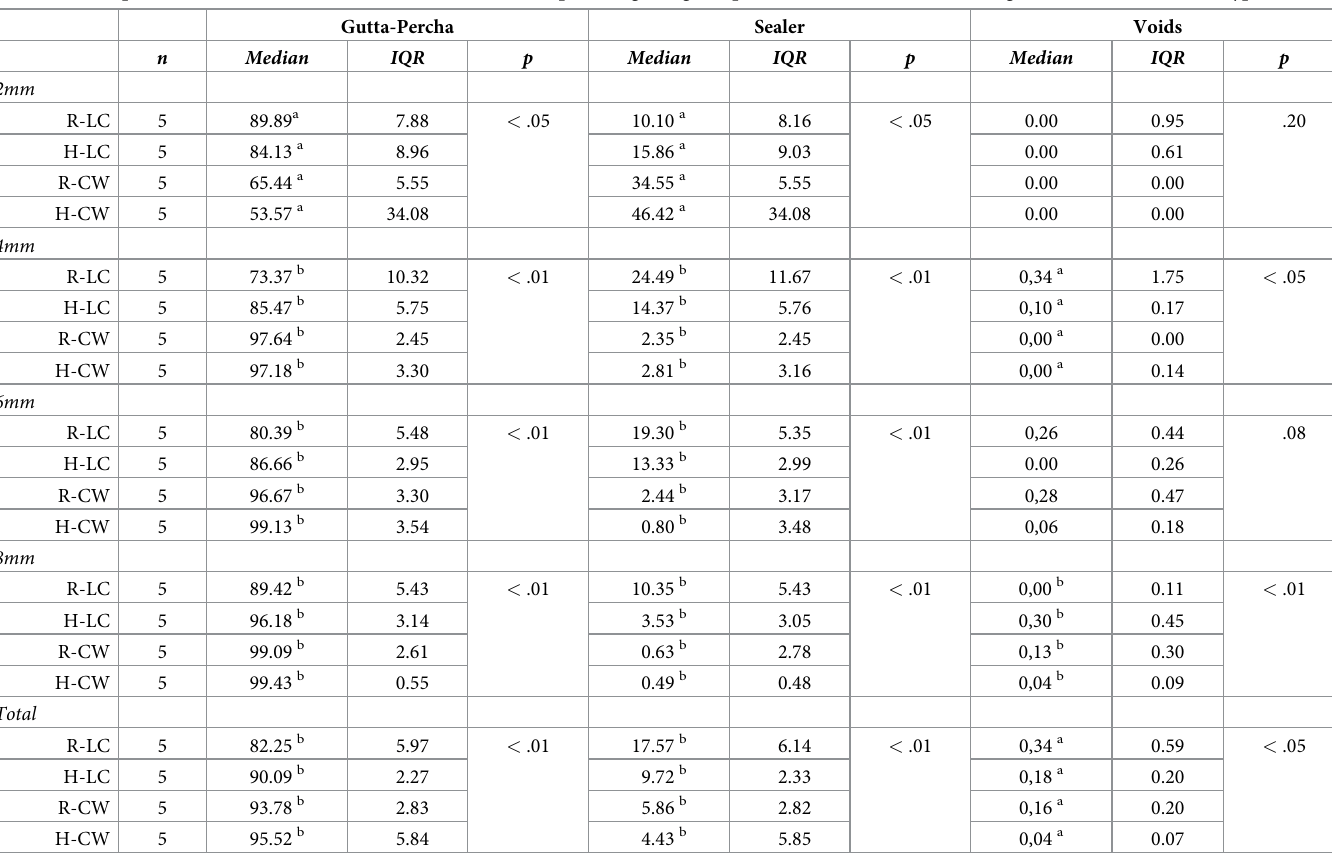
Table 3. Descriptive statistics and Kruskal-Wallis test results on the percentages of gutta-percha, sealer and voids according to level of sections in C1-type.